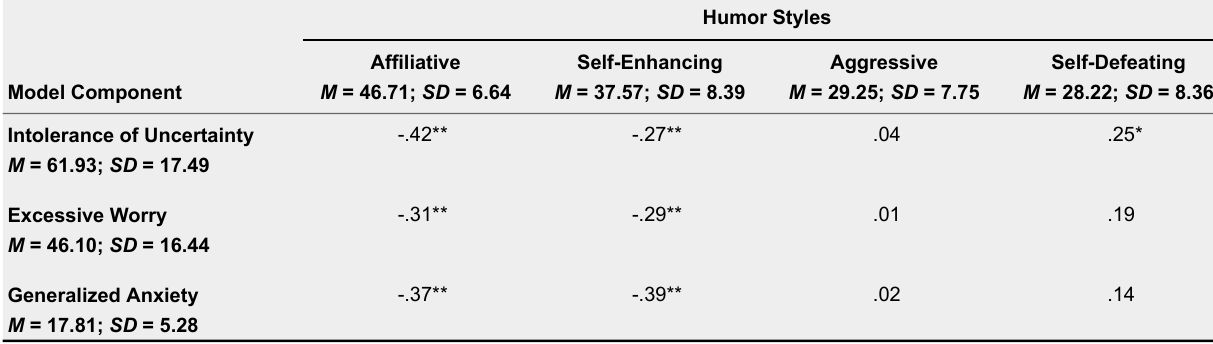
Correlations Between the Humor Styles and Primary Components of the Intolerance of Uncertainty Model of Generalized